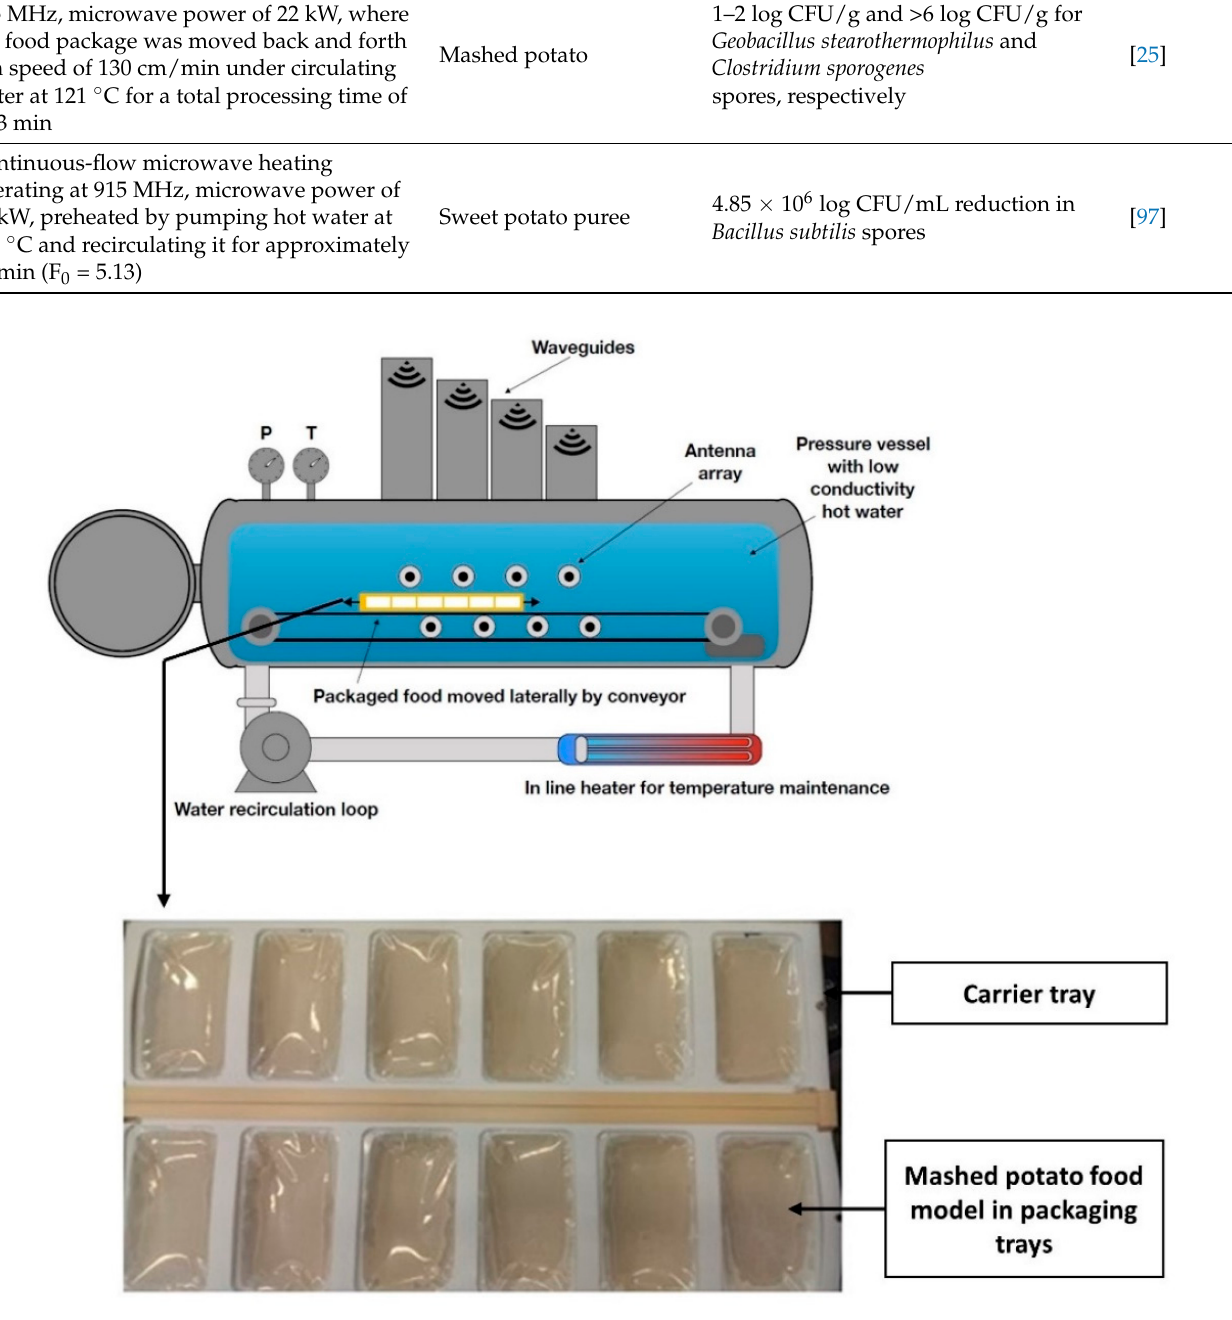
Figure 3. Schematic representation of batch processing model for microwave sterilization, also known as coaxially-induced microwave pasteurization and sterilization (CiMPAS), where the packaging trays are arranged in carrier tray while kept immersed in hot/warm water inside the pressure vessel [25]. (Reprinted from Development of Bacterial Spore Pouches as a Tool to Evaluate the Sterilization Efficiency—A Case Study with Microwave Sterilization Using Clostridium sporogenes and